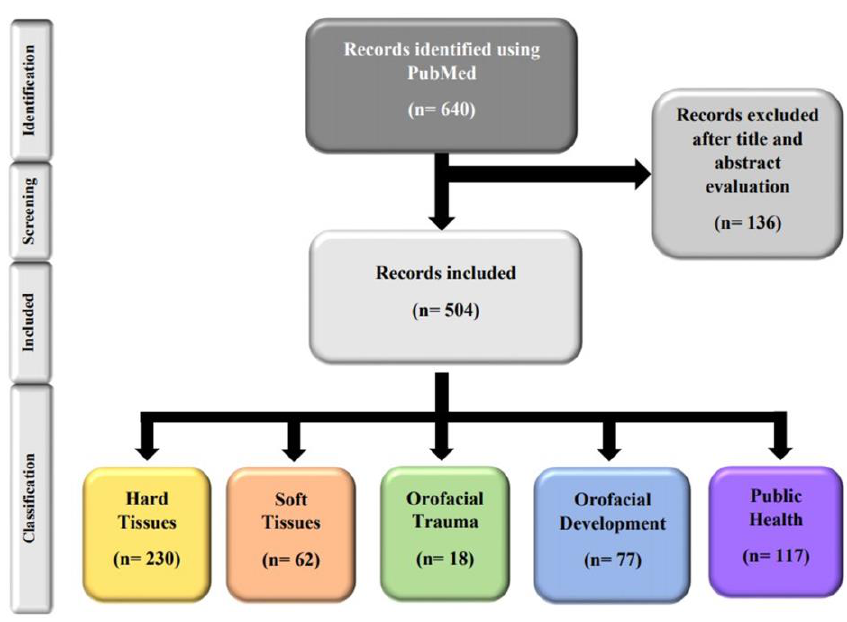
Figure 1. PRISMA flow diagram.